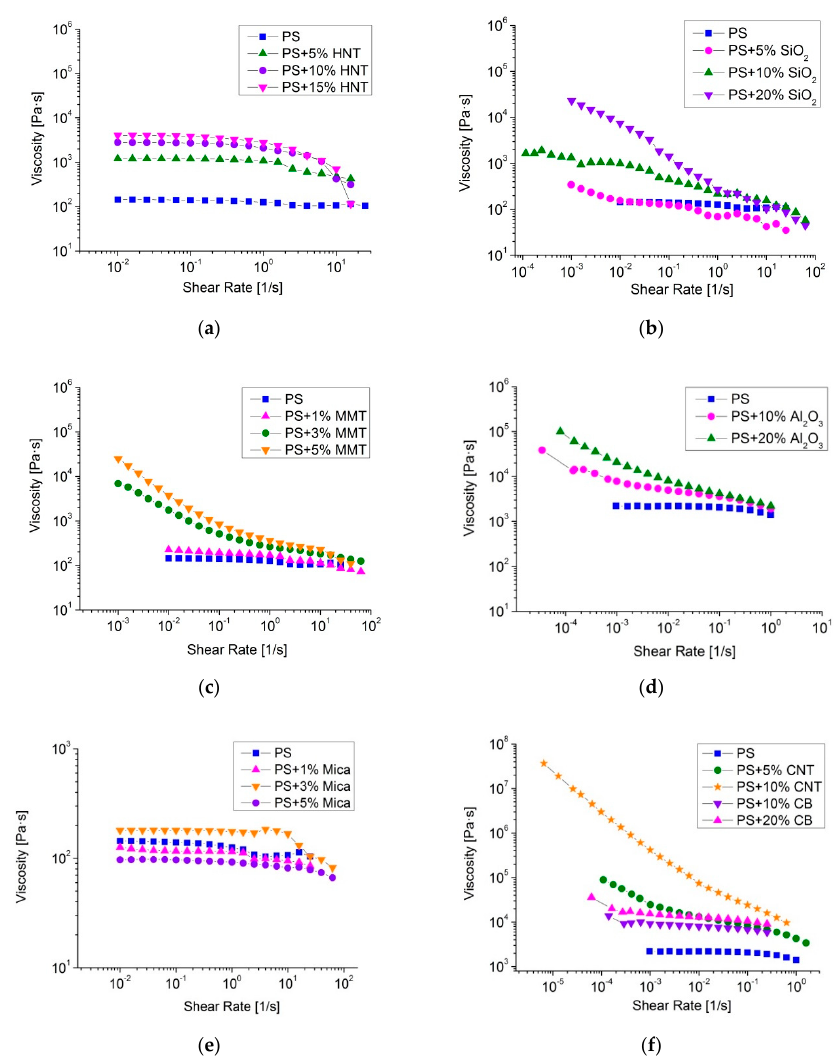
Figure 2. Experimental dependencies of viscosity on shear rate for pure PS and PS-based composites filled with: halloysite natural tubules at 220 °C ( a ); silicon dioxide at 220 °C ( b ); montmorillonite (MMT) at 220 °C ( c ); alumina nanoparticles at 200 °C ( d ); mica at 220 °C ( e ) and carbon nanoparticles at 200 °C ( f ).